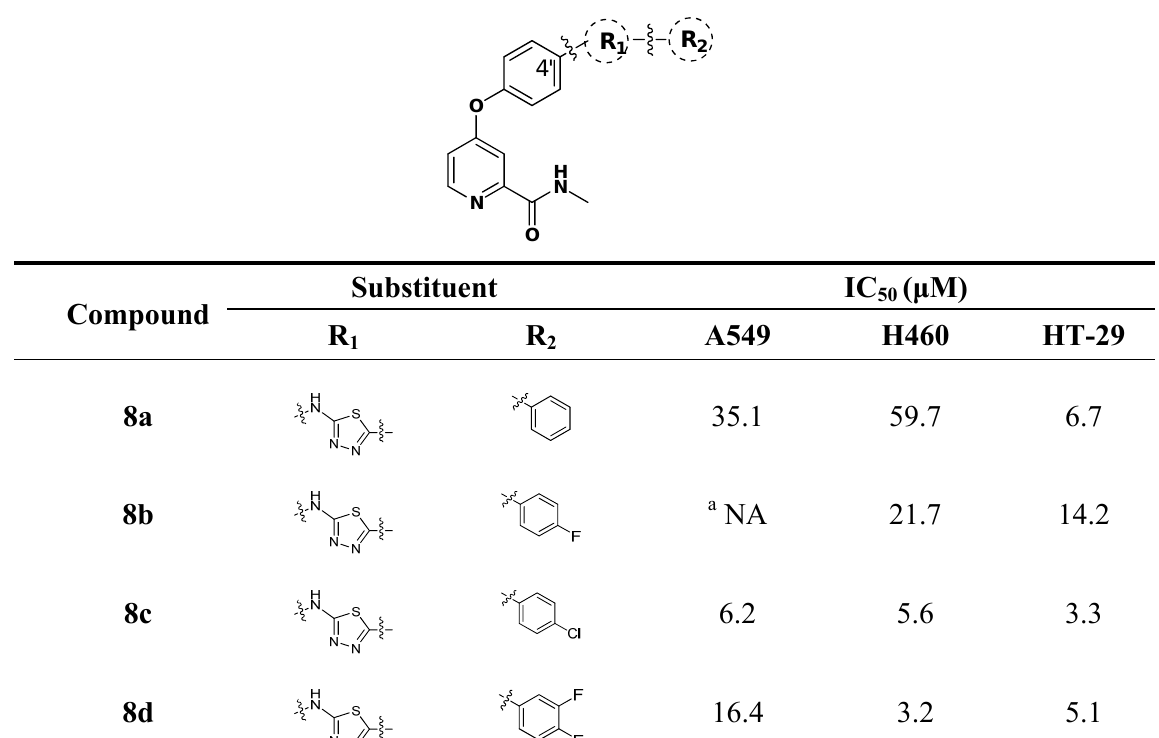
Table 1. Cytotoxic activity of target compounds against A549, H460 and HT-29 cell lines in vitro .